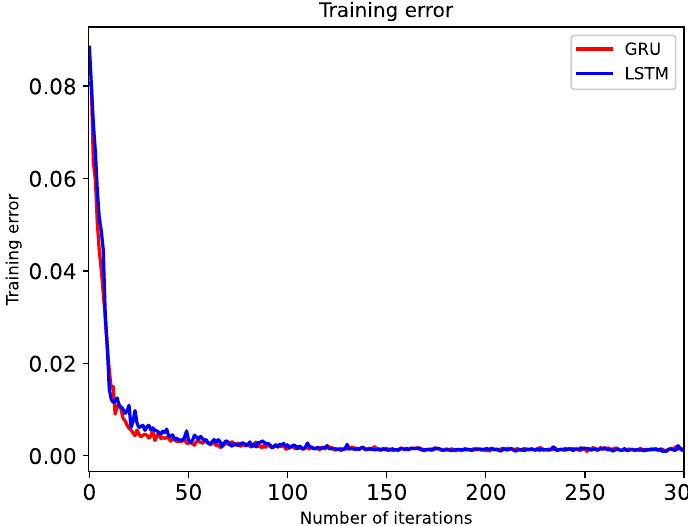
Figure 16. Plot of comparison of prediction accuracy diagram of two models.